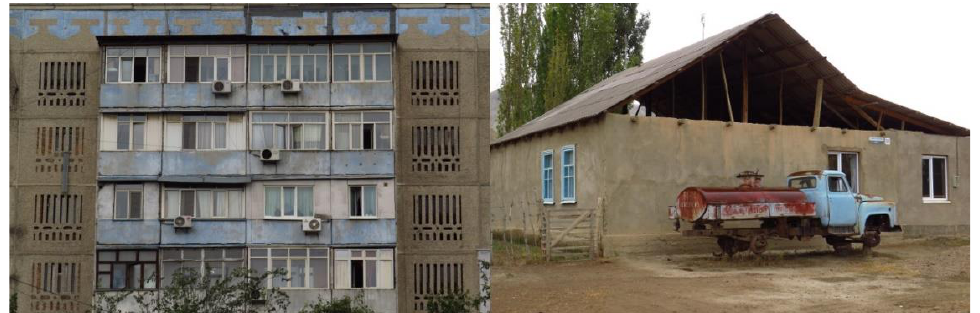
Figure 5. A multi-apartment building in the capital city (Bishkek) and a single-family house in rural Ak-Tal (Source: Author).